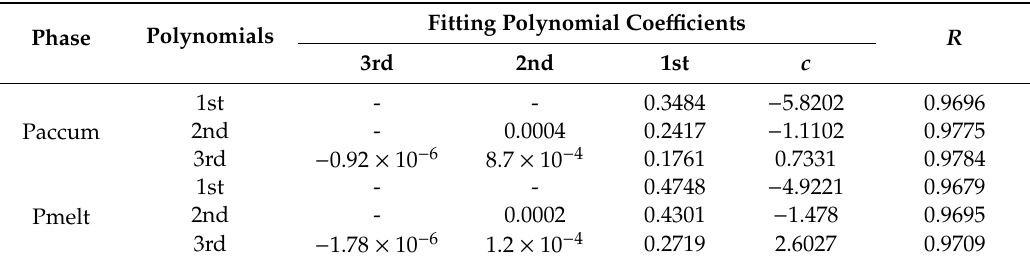
Table 3. Mean, STD and RMS of errors of fitting models for Paccum and